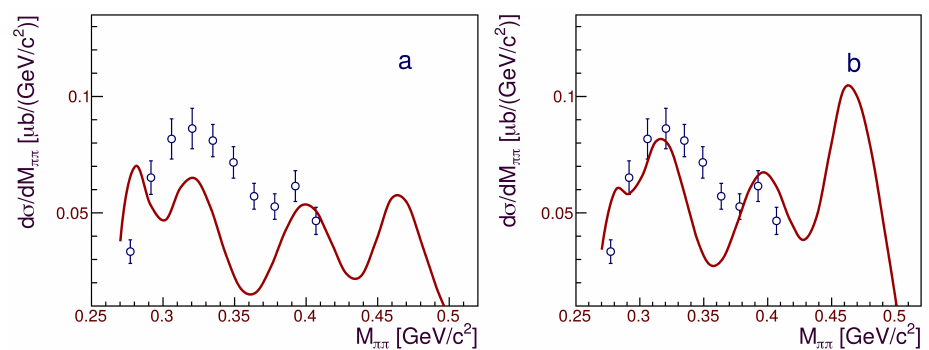
Figure 5: The distribution over the invariant mass of two final pions M ππ at the orbital angular momenta L = 2, l the final deuteron belongs to the experimental interval 0 ◦ < θ c . m . the full interval 0 ◦ < θ c . m .